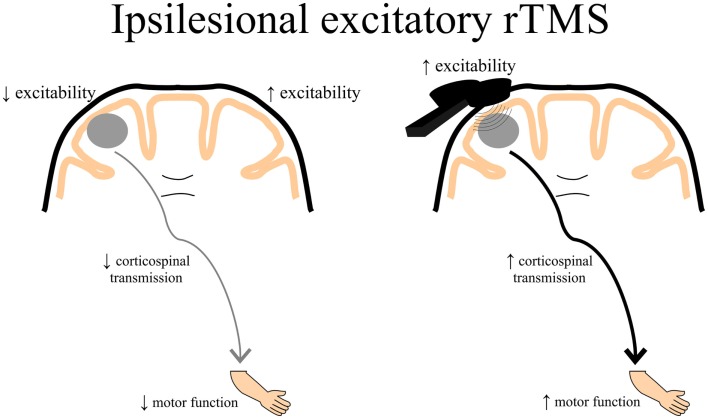
A schematic of the theoretical effects of excitatory rTMS over the ipsilesional cortex. Decreased ipsilesional cortical excitability may contribute to decreased corticospinal transmission resulting in diminished motor function of the paretic upper limb. Ipsilesional excitatory rTMS may increase the excitability of the damaged cortex, thereby contributing to enhanced corticospinal transmission potentially leading to better motor function of the paretic upper limb. rTMS, repetitive transcranial magnetic stimulation.